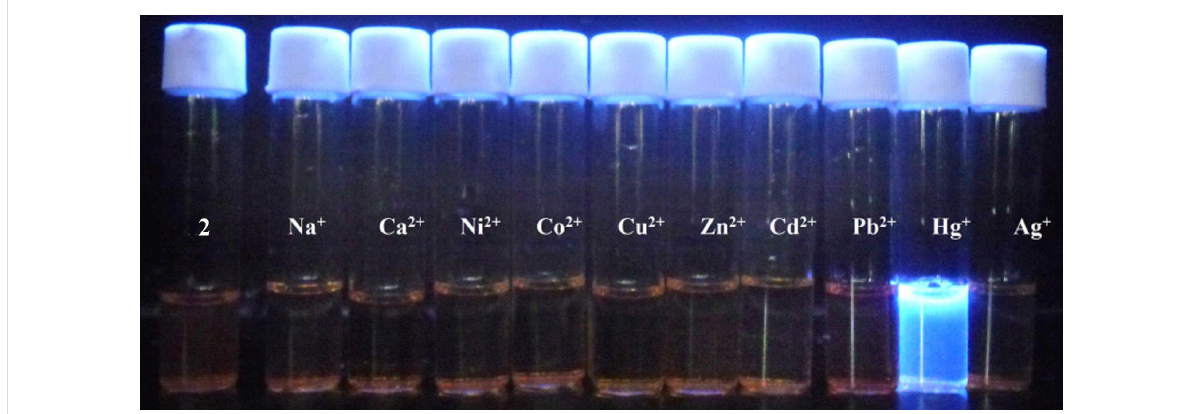
Figure 4: Changes in fluorescence of acrithion 2 upon addition of metal ions in DMSO–H 2 O (70:30 v/v) at pH 7.4.